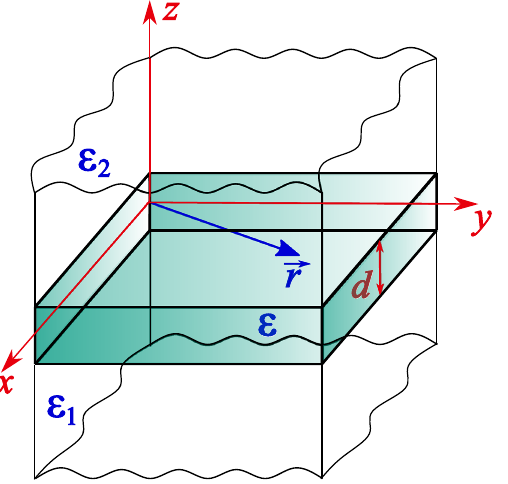
Figure 1. Geometry of the problem under consideration. Thin semiconducting film of thickness d and dielectric permittivity ε is placed between substances with dielectric constants ε 1 and ε 2 . 2D radius-vector r in the xy plane is also shown.